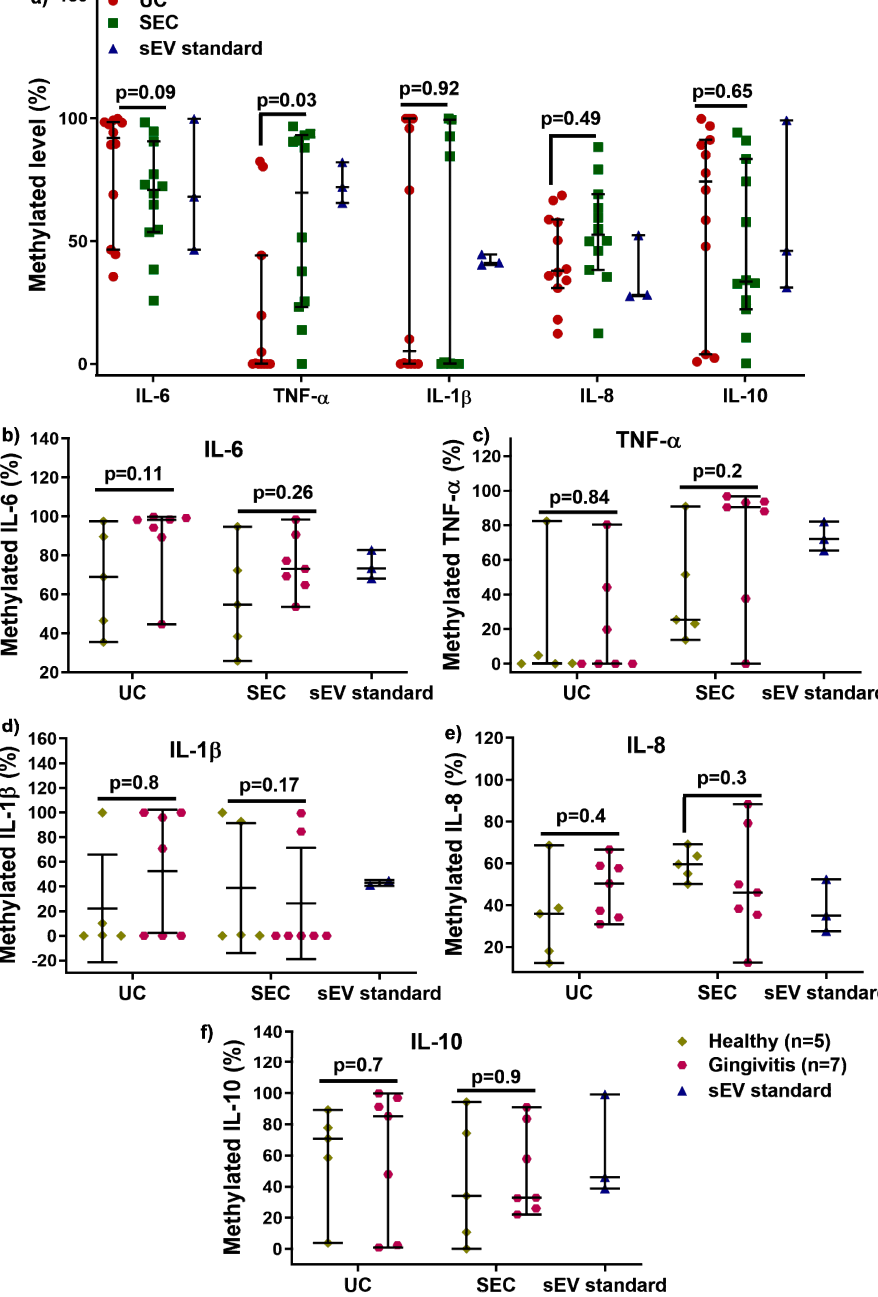
Figure 4. Comparison of UC and SEC on IL 6, TNF α , IL 1 β , IL 8, and IL 10 gene promoter